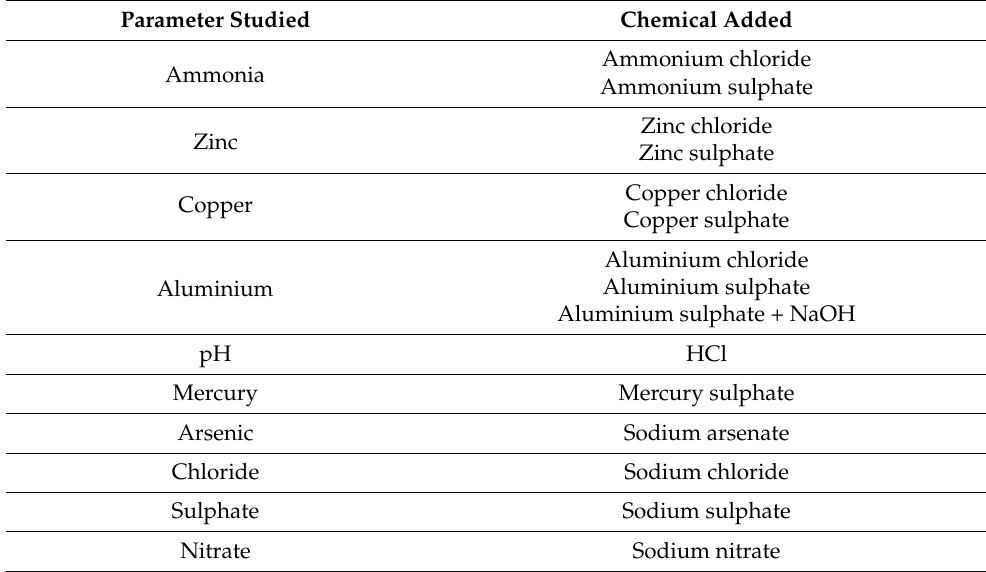
Table 2. Salts added to the biological methane potential